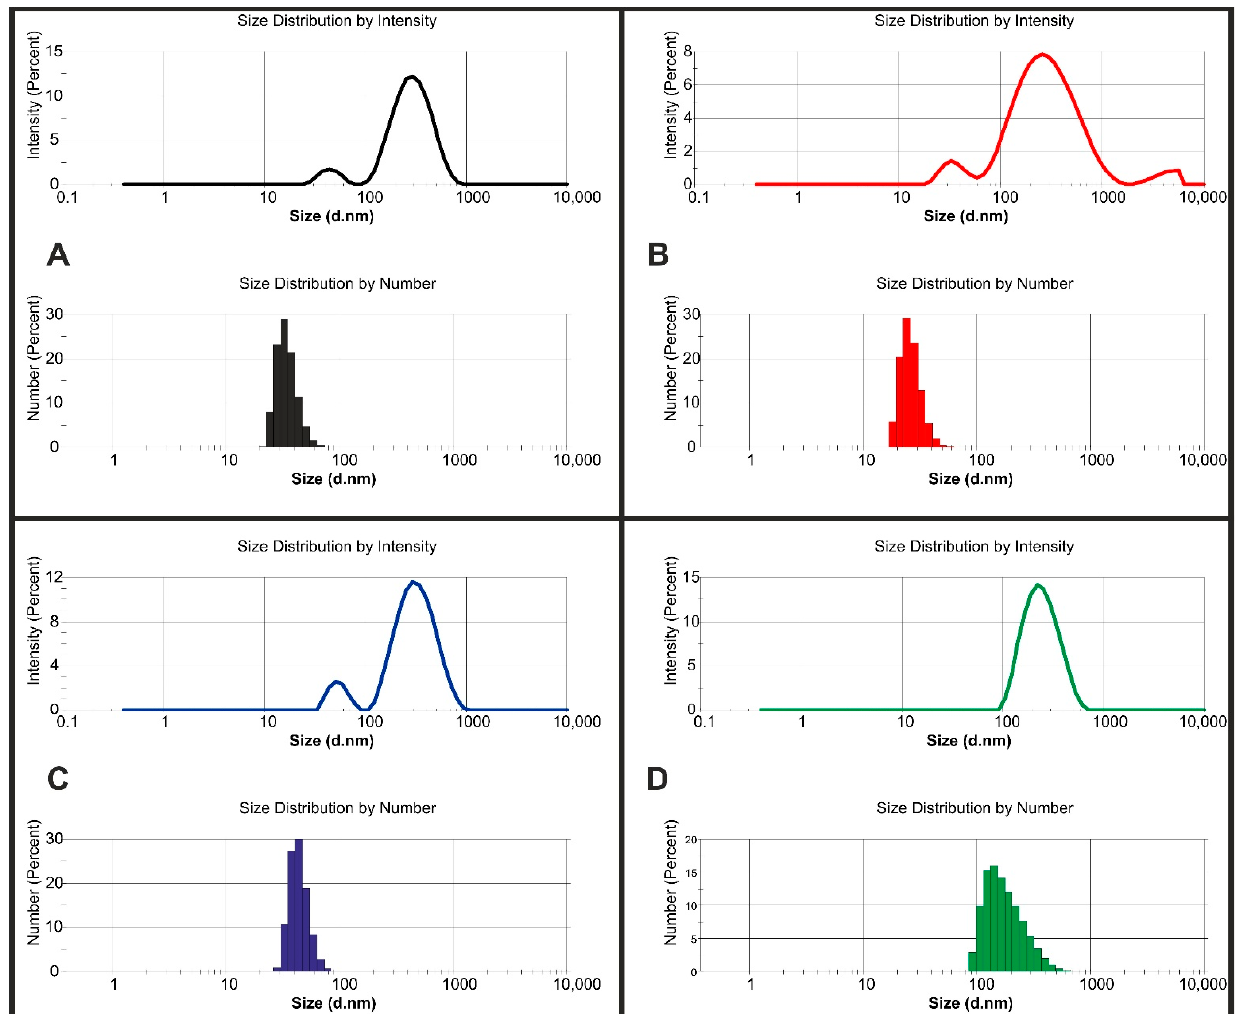
Figure 2. Droplet size distribution by intensity and by number: ( A ) S02, ( B ) S08, ( C ) S13, ( D ) S14.